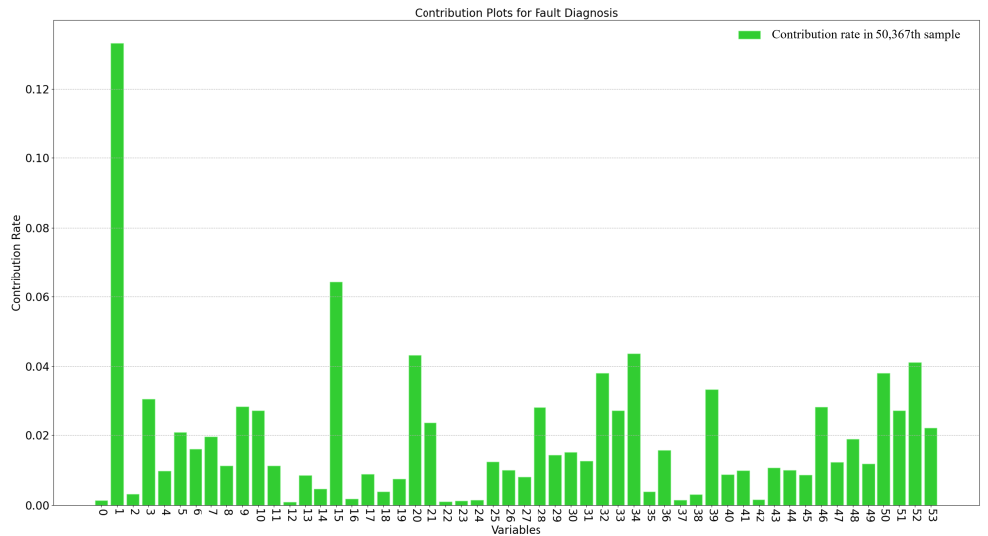
Figure 14. Contribution plots calculated in 50,367th sample.